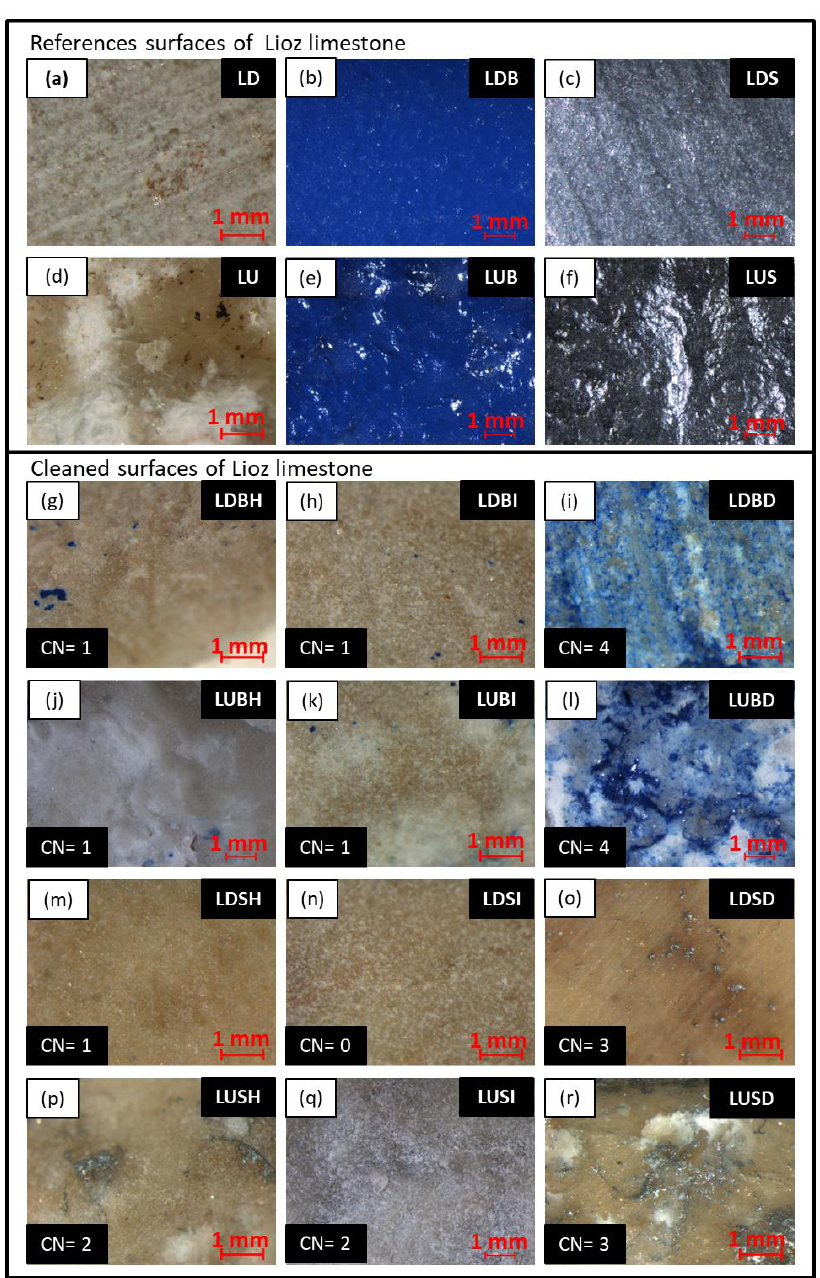
Figure 3. ( a – f ): References surfaces of Lioz limestone (disc-cutting and bush-hammering surfaces, unpainted and painted with blue and silver graffiti paints). ( g – r ): Limestone surfaces cleaned of blue ( g – l ) and silver ( m – r ) graffiti paints with Hydrogommage, IBIX, and dry-ice blasting. See Table 1 for samples’ nomenclature.